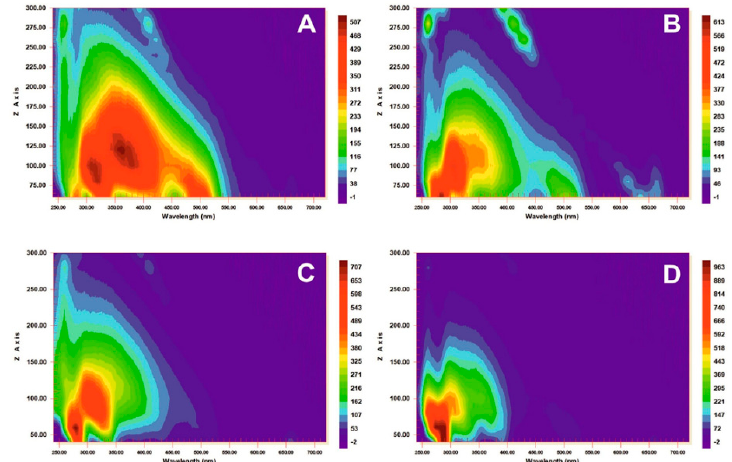
Figure 3. Synchronous fluorescence spectra of testa from field bean ( Vicia faba var. minor ) cultivars seeds